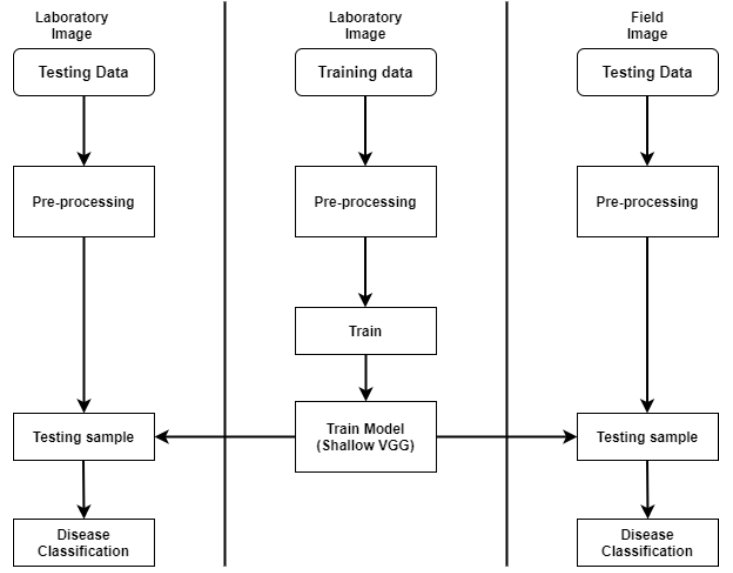
Figure 1. Overall flow diagram of plant disease identification